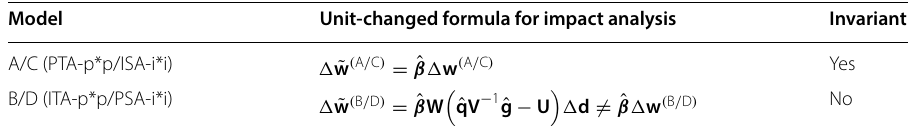
Table 5 Results of a change in accounting units in the expressions for the satellite vector for models A–D Model Unit-changed formula for impact analysis